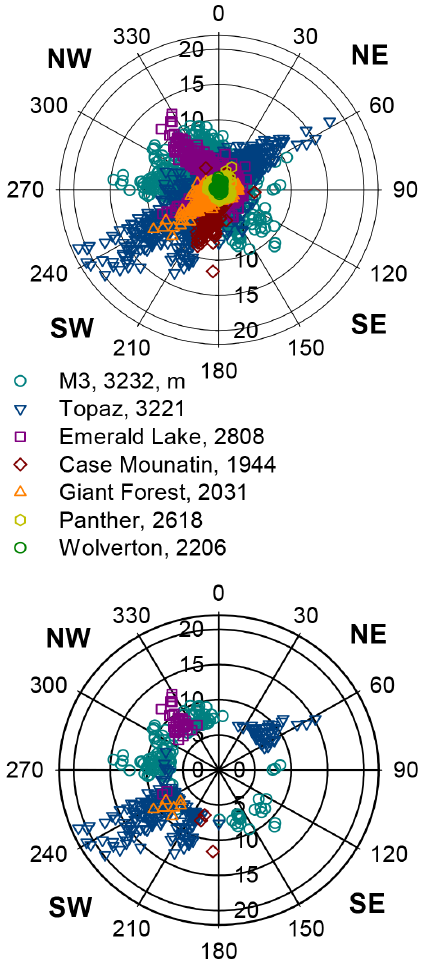
Figure 3. Top: hourly average wind speed and direction for 3 December–23 March accumulation period. Bottom: periods with highest probability of snow redistribution. Radius scale in ms − 1 , azimuth in degrees, and north at 0